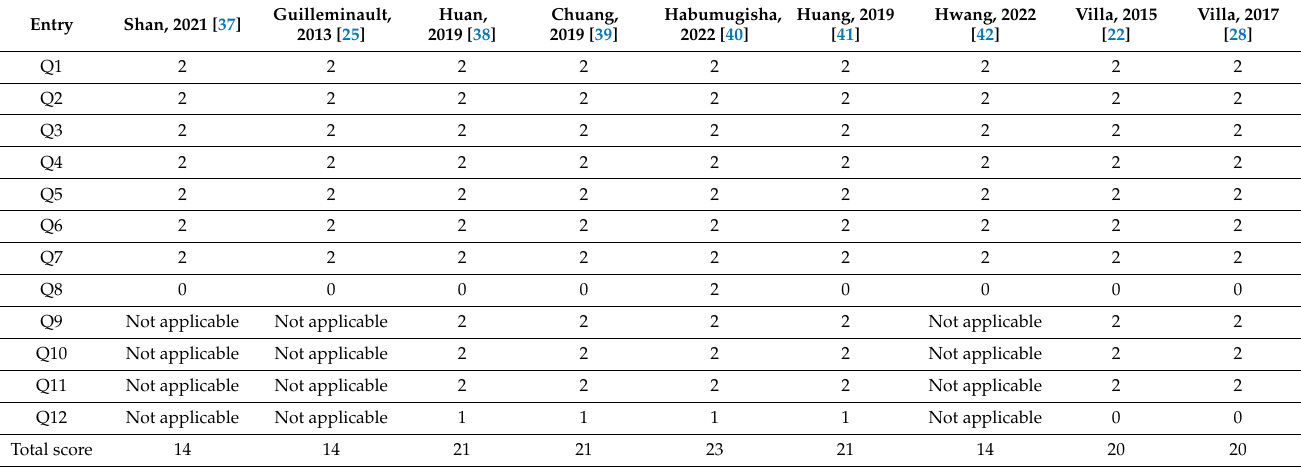
Table 3. Application of MINORS in Literature Quality Evaluation.